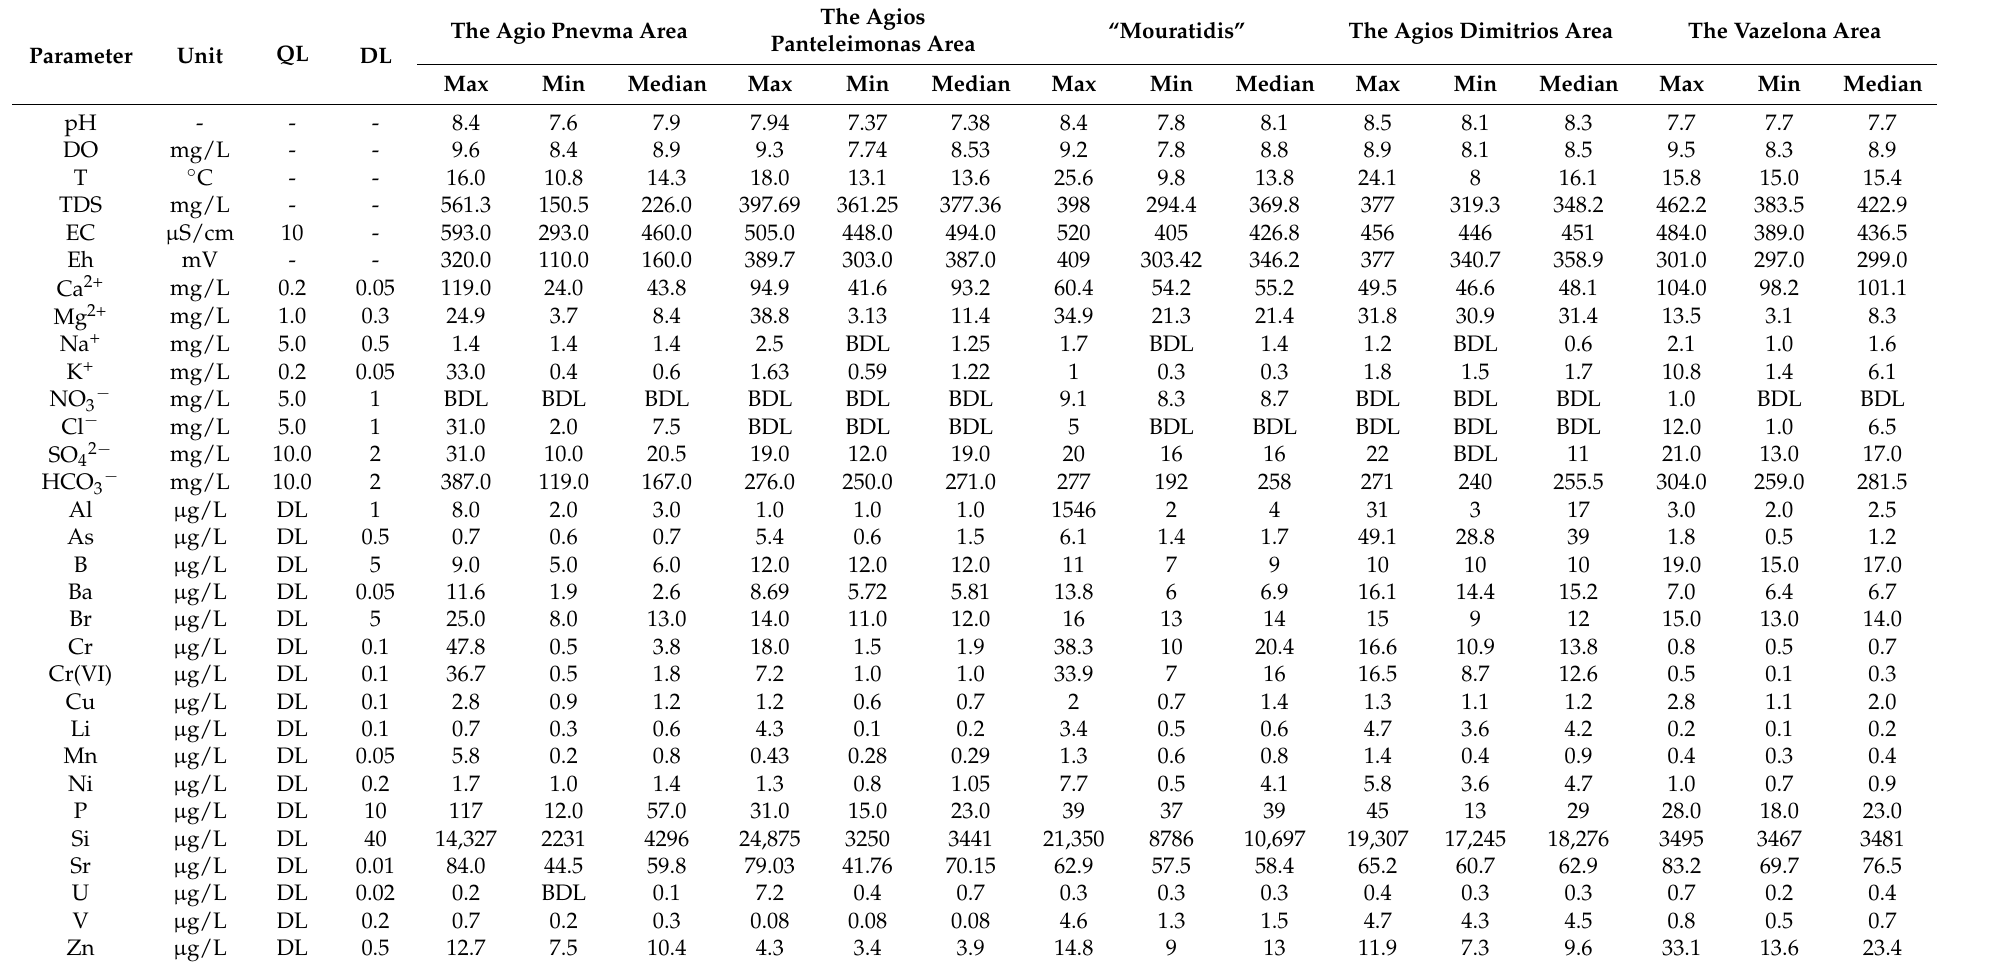
Table 1. Maximum, minimum, and median values of physical and chemical parameters of natural springs in western Vermio